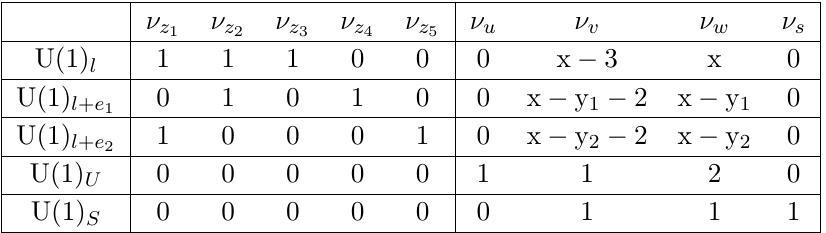
(cid:12)bration over dP 2 112